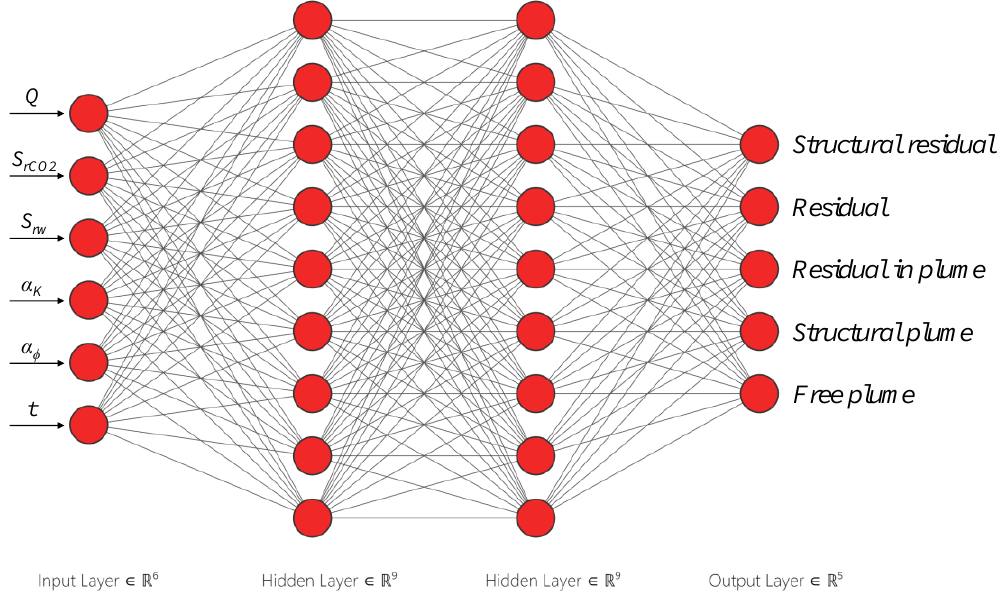
Figure 4. Schematic showing our ANN model architecture, including input, hidden, and output layers.